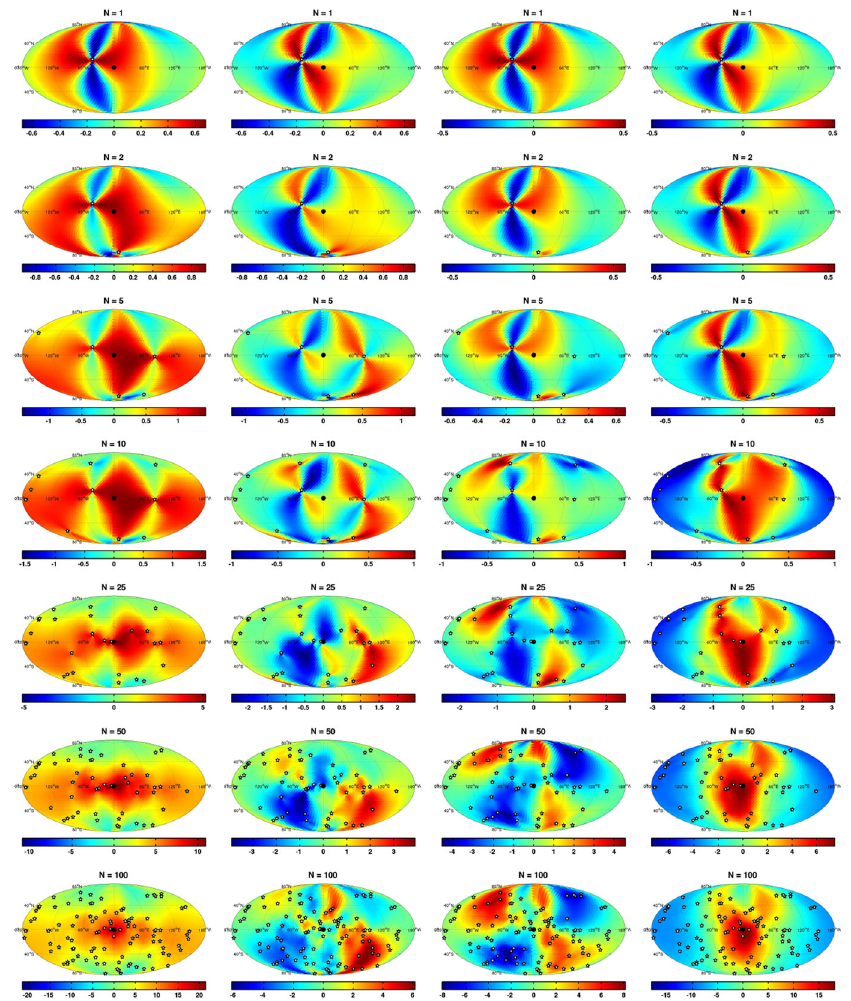
Fig. 53 Point spread functions for phase-coherent mapping, for pulsar timing arrays consisting of N = 1, 2, 5, 10, 25, 50, 100 pulsars. The point source is located at the center of the maps, (θ,φ) = ( 90 ◦ , 0 ◦ ) , indicated by a black dot . The pulsar locations (indicated by white stars ) are randomly placed on the sky. Different rows correspond to different numbers of pulsars in the array. Columns 1 and 2 correspond to the + and × response of the pulsar timing array to a + -polarized point source; columns 3 and 4 correspond to the + and × response of the pulsar timing array to a × -polarized point